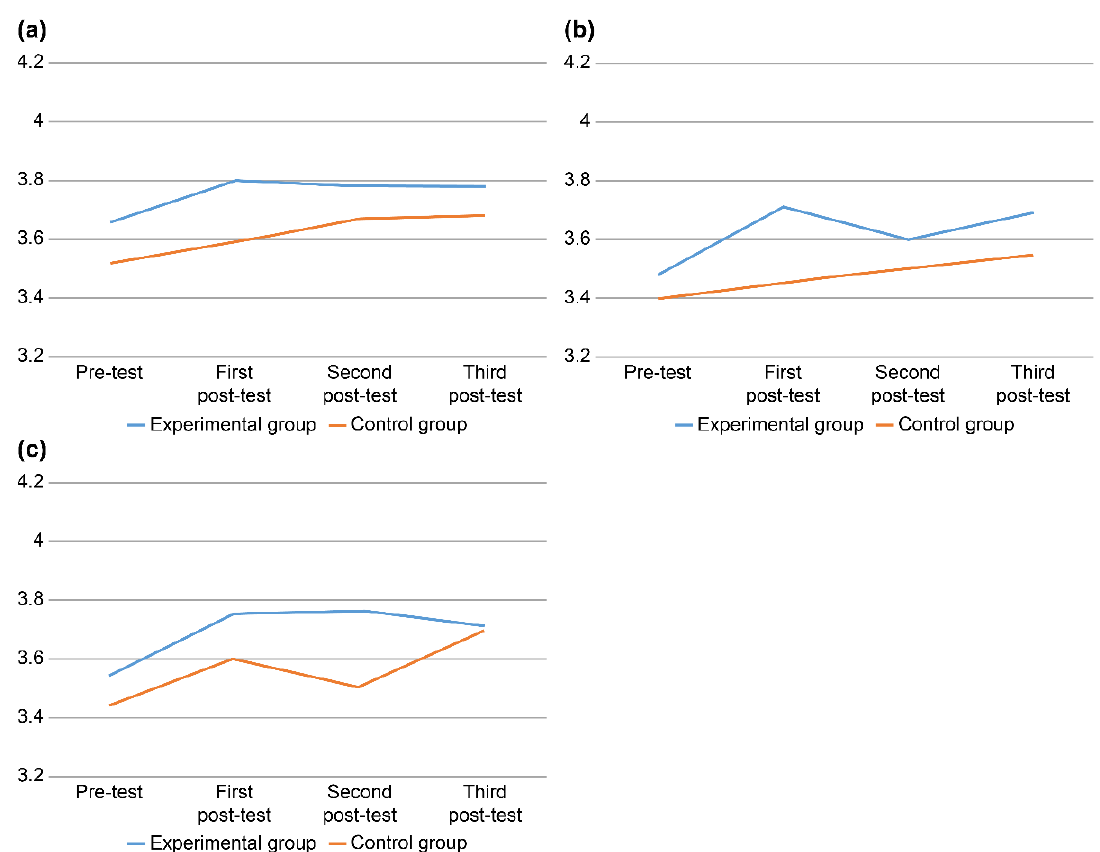
Figure 2. Effects of the “High-Up” program on the ( a ) Communication ability, ( b ) Critical-thinking tendency, ( c ) Problem-solving ability.